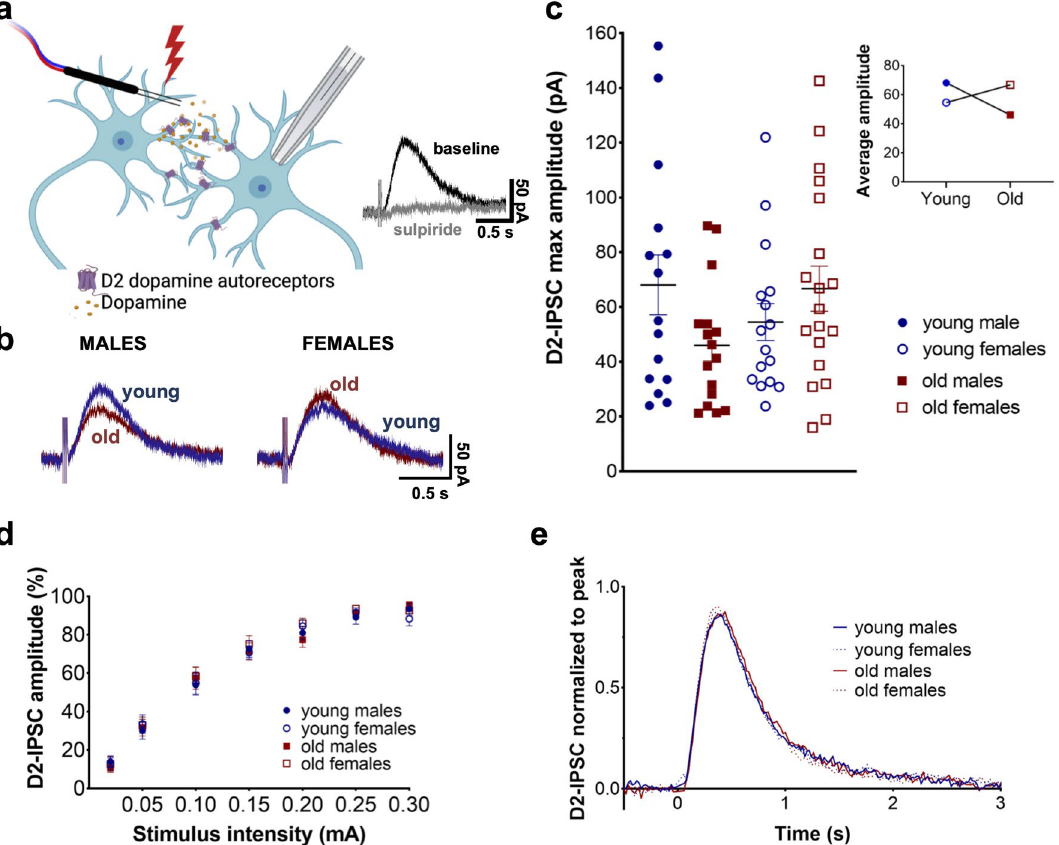
Figure 1. Effect of age and sex on D2 receptor inhibitory postsynaptic currents. ( a ) Schematic diagram of stimulation of sulpiride-sensitive D2-IPSCs. ( b ) Representative traces of D2-IPSCs from old versus young males and females. ( c ) Maximum amplitude of D2-IPSCs for each individual cell for all groups. Inset shows means for all groups with a significant sex x age interaction ( p = 0.0383). ( d ) Normalized stimulus–response curves show no differences between groups. ( e ) Kinetic analysis of D2-IPSCs amplitudes normalized to maximum outward current show no effect of age or sex. Diagram was created with